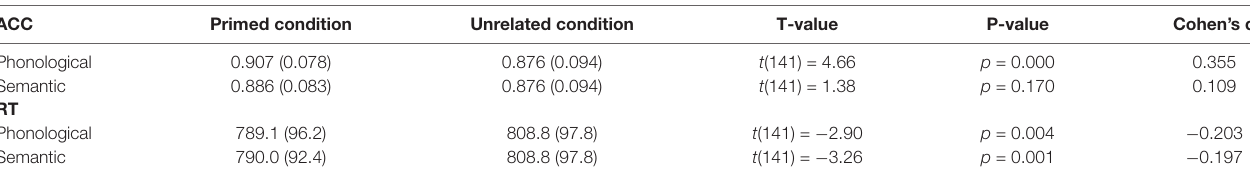
TABLE 2 | Results of paired t -test of ACC and RT between primed and unrelated conditions with Cohen’s d for effect